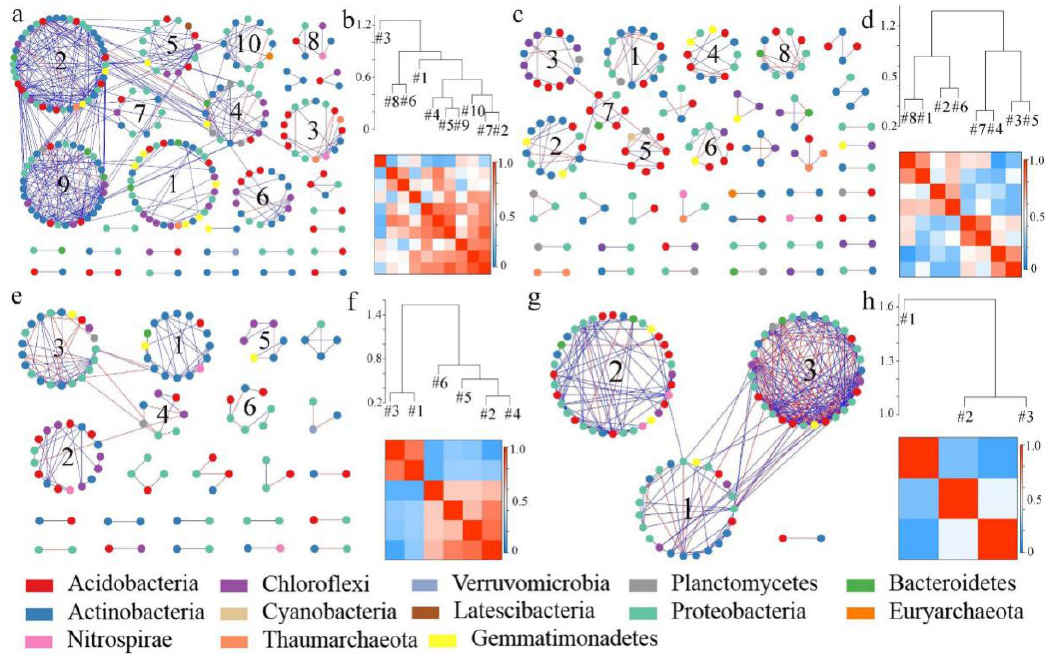
Figure 5. Soil bacterial molecular ecological networks and module eigengene hierarchy structure in a mining subsidence area and vegetation rehabilitation area. ( a ) and ( c ) represent the soil bacterial molecular ecological network in the mining subsidence area and its control. ( e ) and ( g ) represent the soil bacterial molecular ecological network in vegetation rehabilitation area and its control. ( b ) and ( d ) represent the soil bacterial modular eigengene hierarchy structure in mining subsidence area and its control. ( f ) and ( h ) represent soil bacterial modular eigengene hierarchy structure in the vegetation rehabilitation area and its control. The connecting line represents the interaction of the target level on phylum, with blue representing positive and red representing negative interaction.